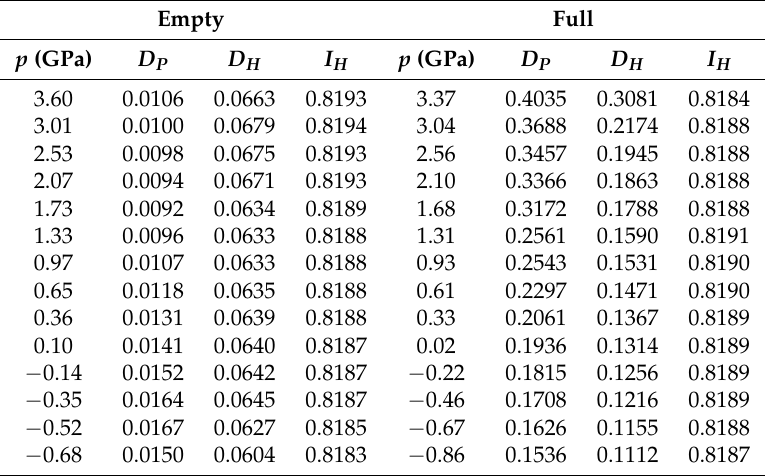
Table 2. Pressure dependence of cage deformation parameters for the empty and full